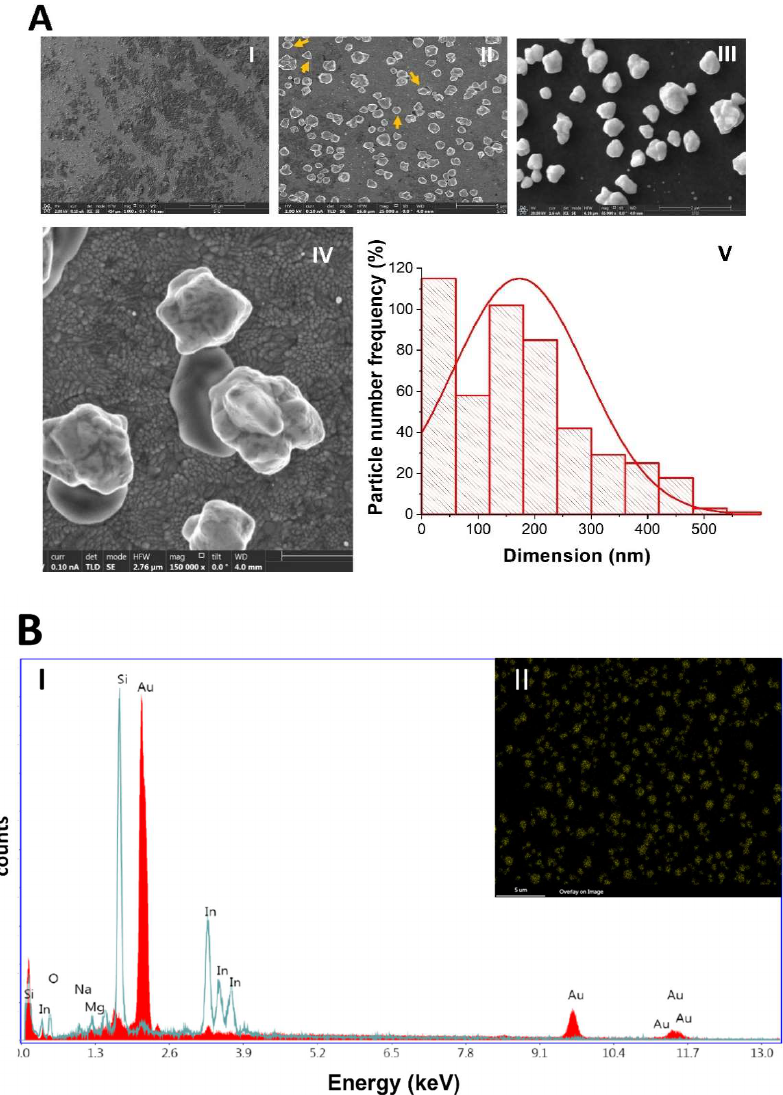
Figure 2. ( A ) SEM images at different magnifications of (I) 1000×, (II) 25,000×, (III) 65,000× and (IV) 150,000×. (V) The size distribution of AuNP images from SEM. ( B ) (I) EDX spectrum of AuNPs and (II) SEM/EDX mapping distribution of Au.